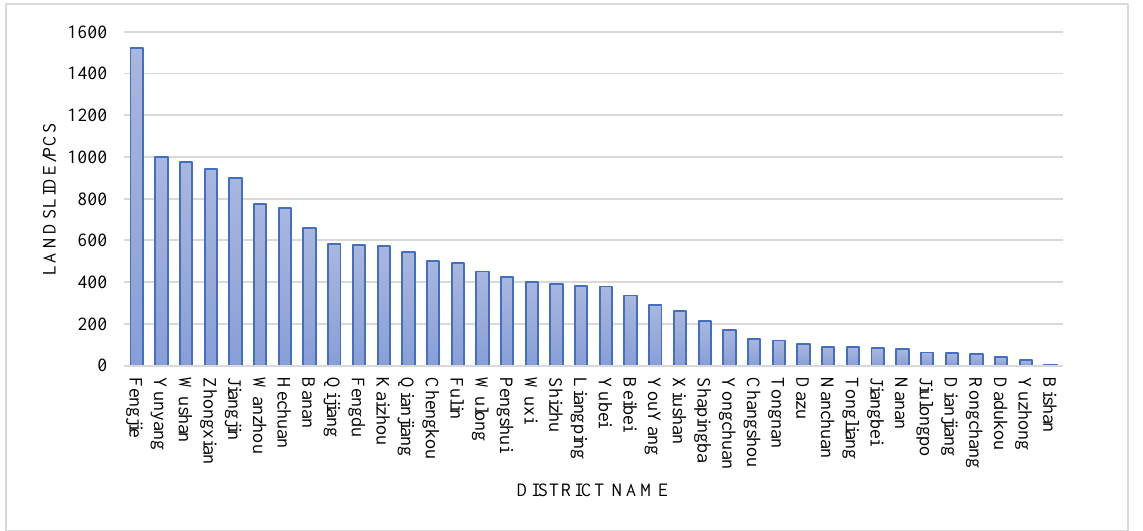
Figure 3. Landslide numbers for the counties of Chongqing from 2001 to 2016.